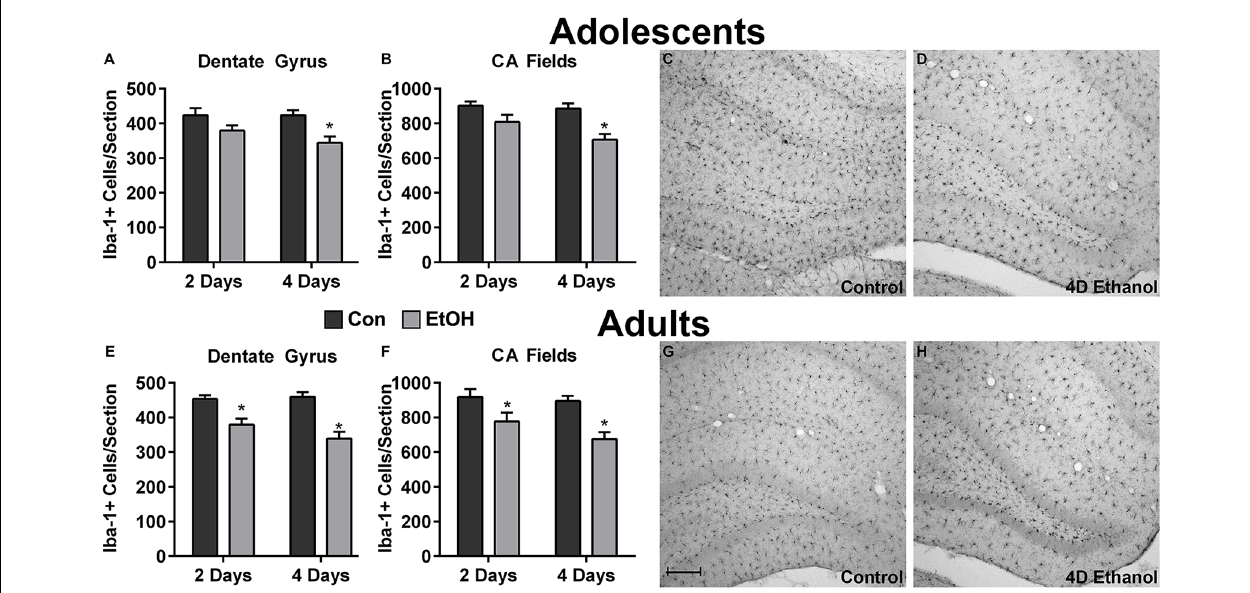
FIGURE 1 | Ethanol decreases microglia numbers in the hippocampus. Ethanol-exposed rats (light gray bars) had fewer Iba1+ cells compared to controls (dark bars) in both adolescents (A,B) and adults (E,F) . Post hoc tests indicated that Iba1+ cells were reduced after 4 days in the adolescent dentate gyrus (A) and CA fields (B) and after both the 2 and 4-day binge in adults in both regions (E,F) . Representative photomicrographs of the dentate gyrus of control-treated adolescent (C) and adult (G) animals have significantly more microglia compared with the photomicrographs of the alcohol-treated corresponding adolescent (D) or adult (H) images. Data are mean ± SEM. Scale bar = 200 µ m, * p < 0.05.